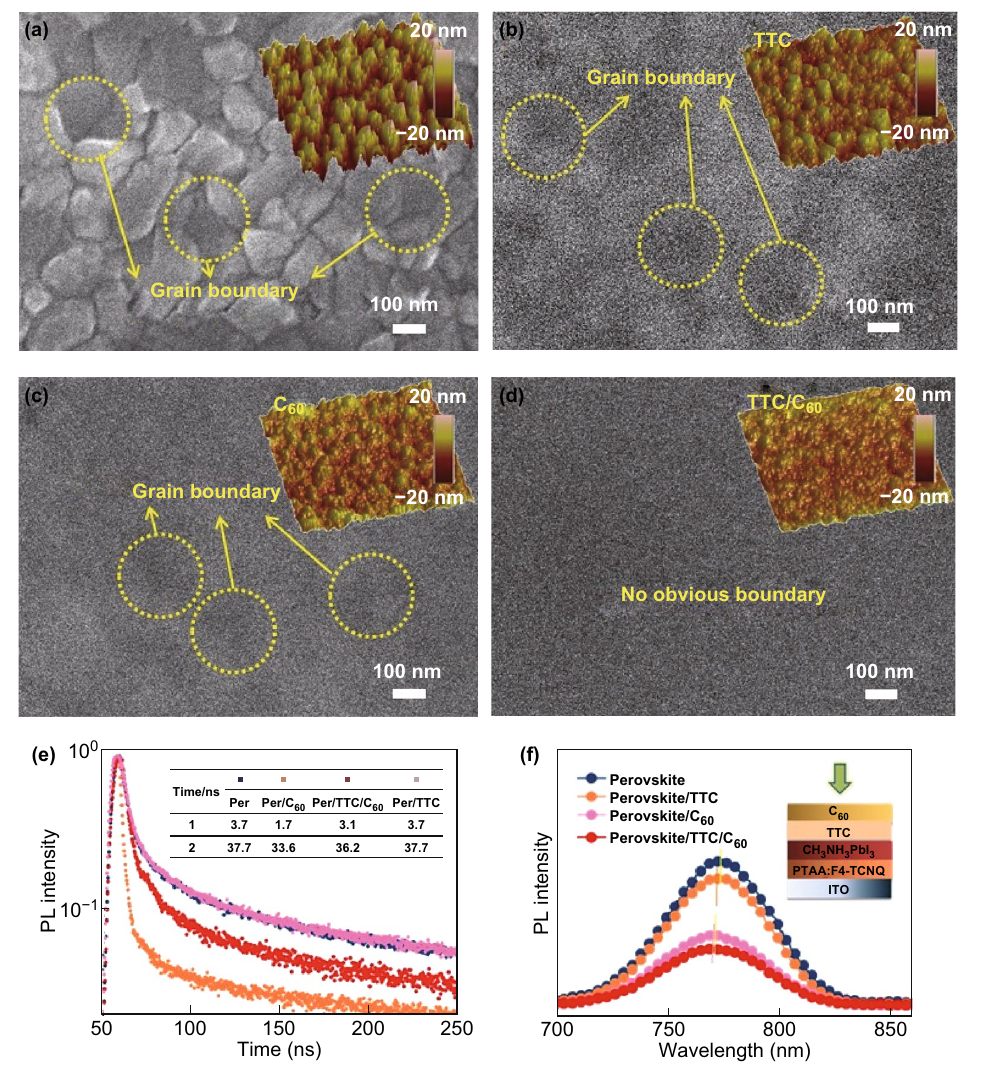
Fig. 2 Top-view SEM and AFM images of a the normal perovskite and the perovskite with b TTC, c C 60 , and d TTC/C 60 (scale bar: 100 nm). e TRPL and f PL spectra of corresponding films on ITO substrate